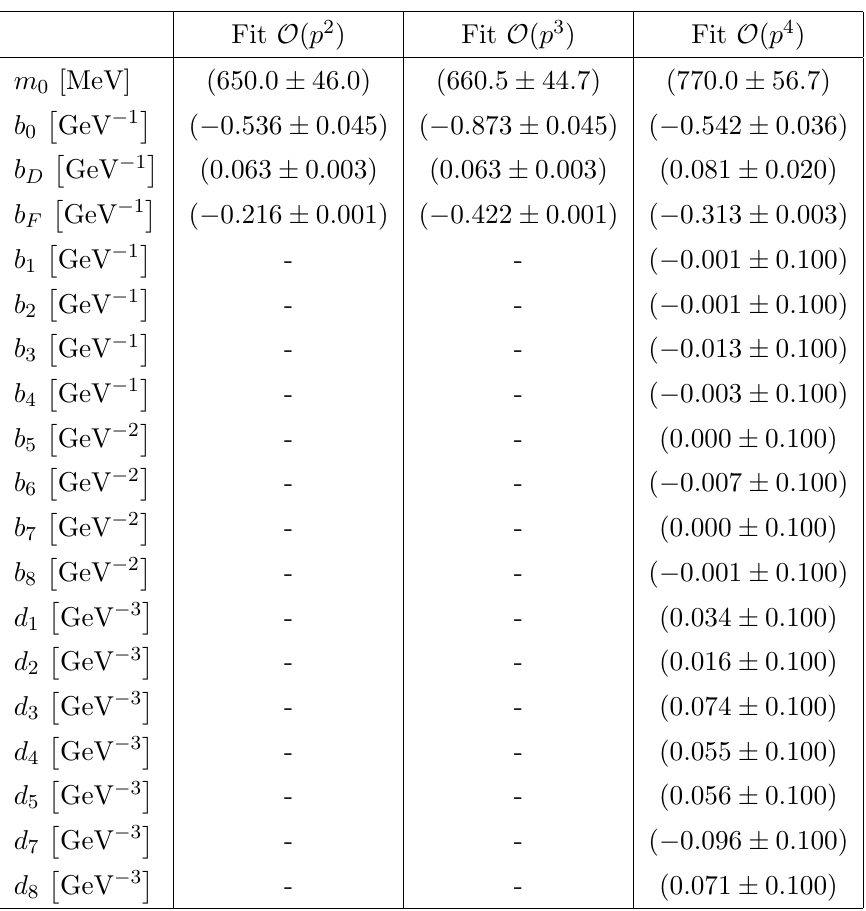
Table 9 . Fitted LECs are second, third and fourth order for the covariant calculation without the decuplet as decribed in the